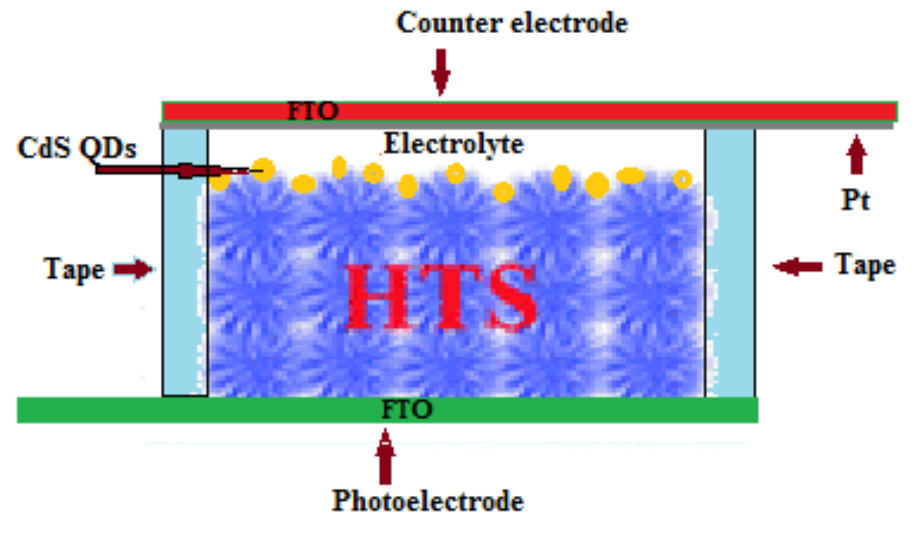
Figure 1. Schematic of the Hierarchical TiO 2 structure (HTS) based quantum dot sensitized solar cell